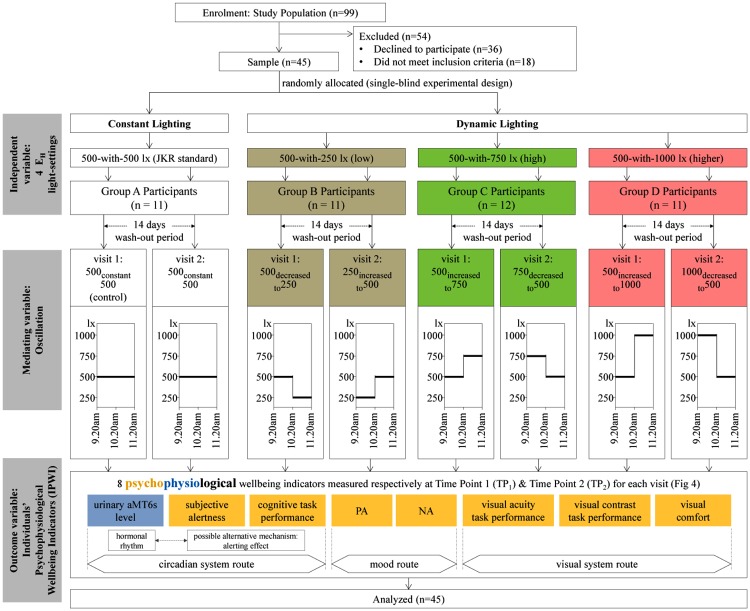
Schematic diagram describing the variables and experimental study design.